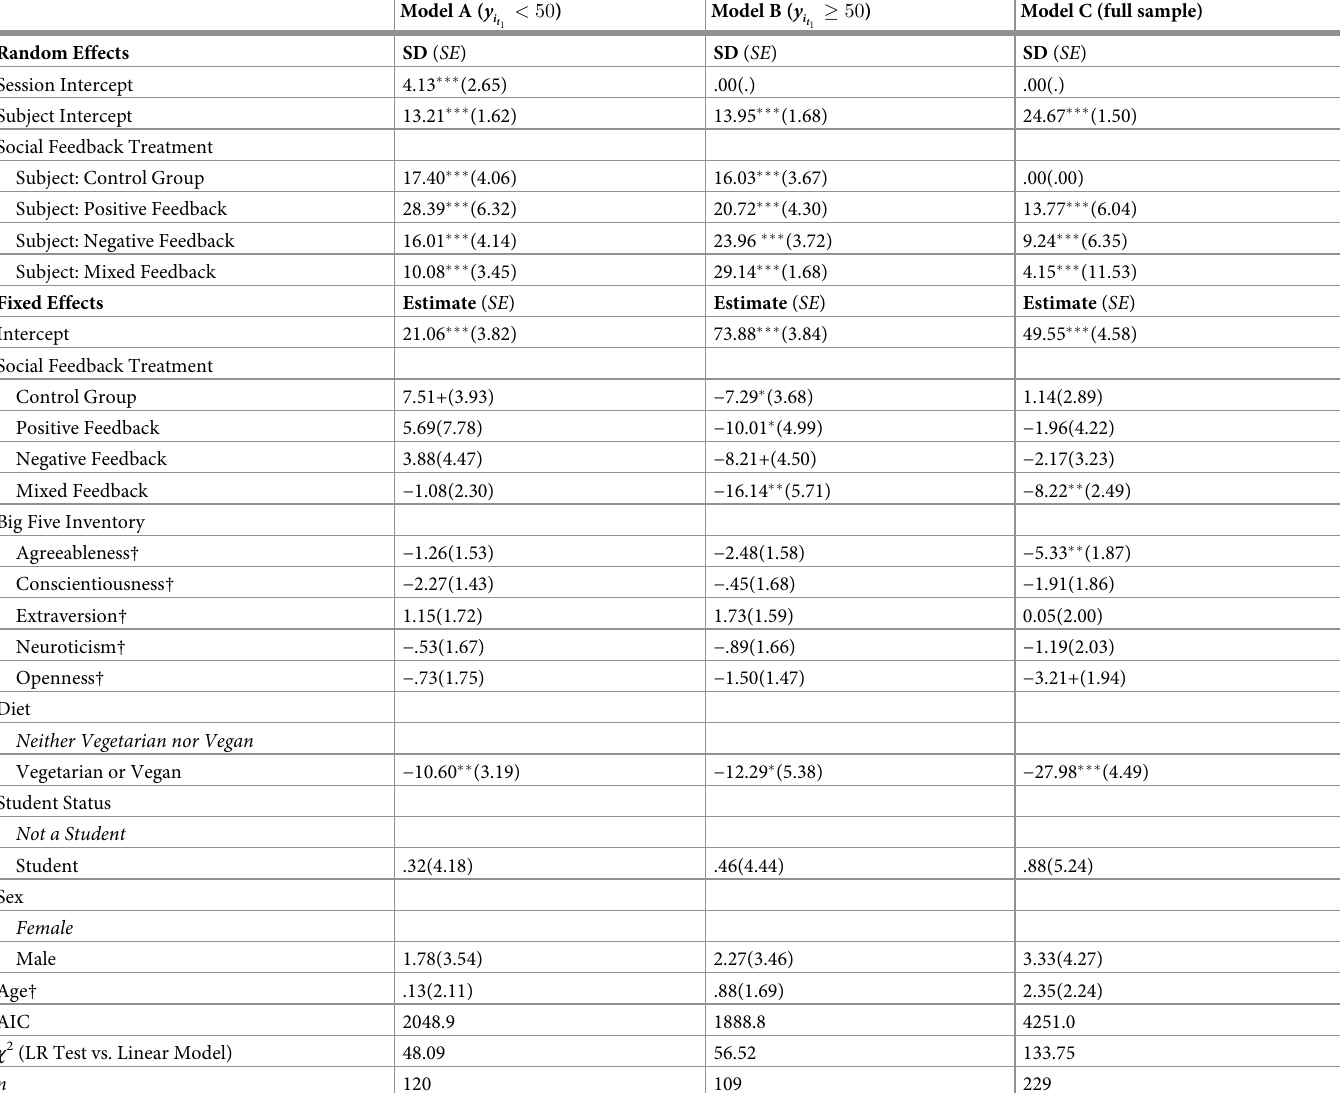
Table 5. Results of the multiple three-level linear mixed-effects regressions on the subjects’ opinion towards the target item